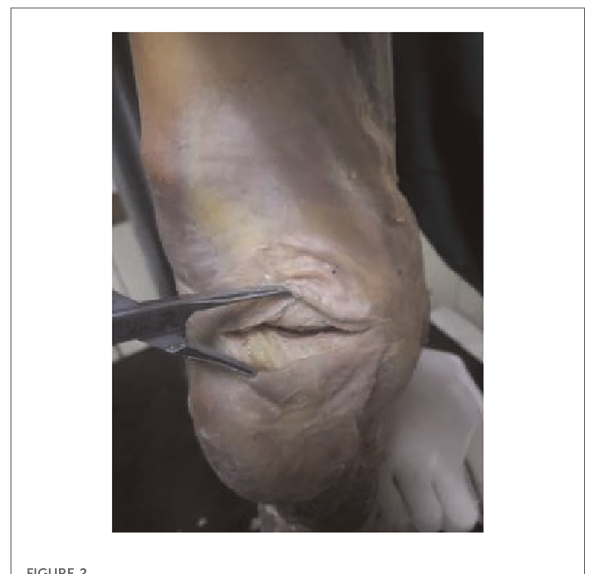
FIGURE 2 Two horizontal incisions about 3 – 4 cm long were